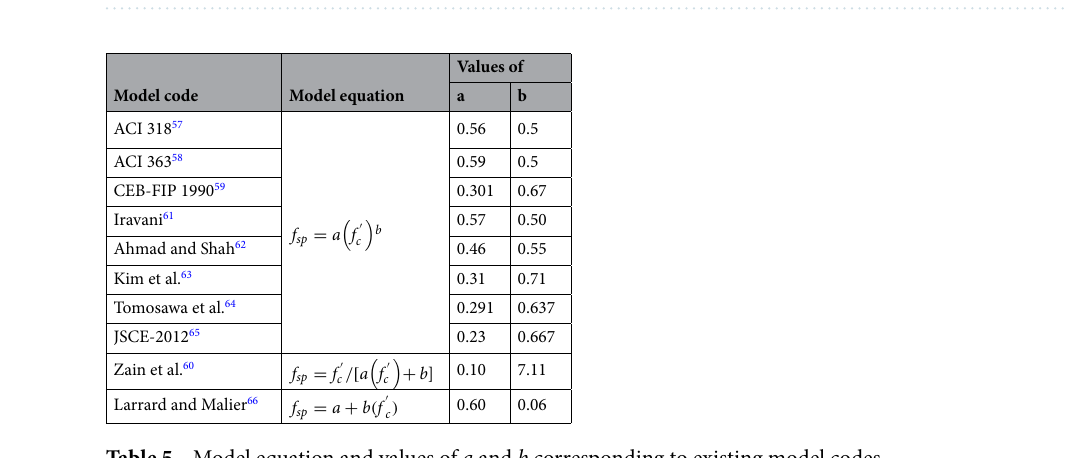
Figure 8. Comparison of experimental tensile and compressive strength relationships of different concrete mixtures with existing prediction models.